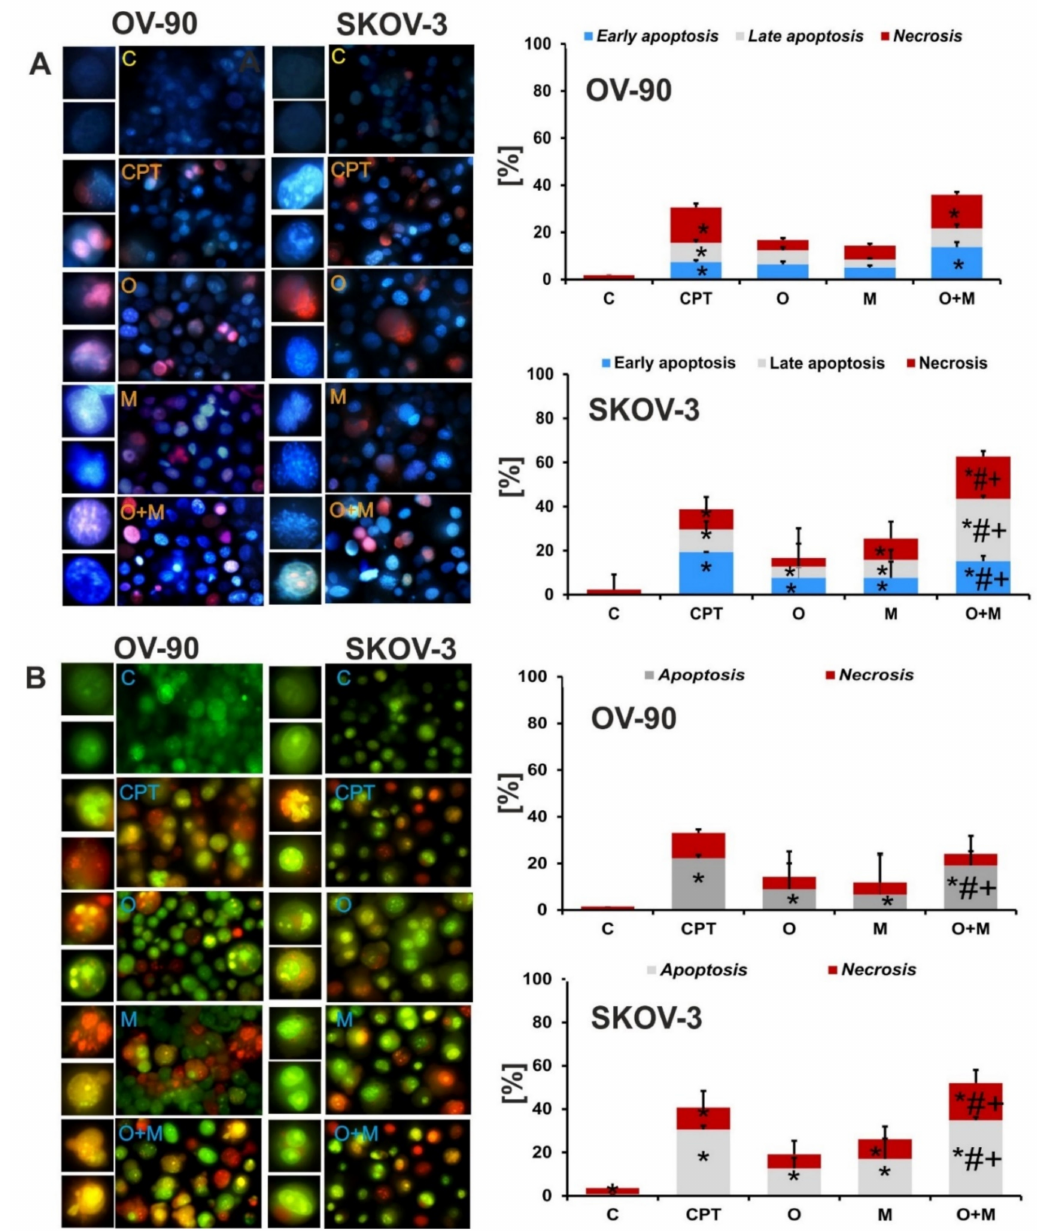
Figure 4. Combination treatment caused a greater cell death in both tested cell lines compared with each drug alone. Representative images of the apoptotic and necrotic changes caused by the compounds; C: control. The cells were visualized under a fluorescence microscope (Olympus IX70). ( A ) Apoptotic and necrotic changes visualized after double staining with Hoechst 33258/propidium iodide. ( B ) Apoptotic and necrotic changes visualized with acridine orange and ethidium bromide staining. Data are from three biologic assays and are graphed as the mean ± SD. * p < 0.05 for olaparib, metformin, or a combination of both drugs vs. control cells; # p < 0.05 for olaparib vs. combination (O + M); and + p < 0.05 for metformin vs. combination (O +